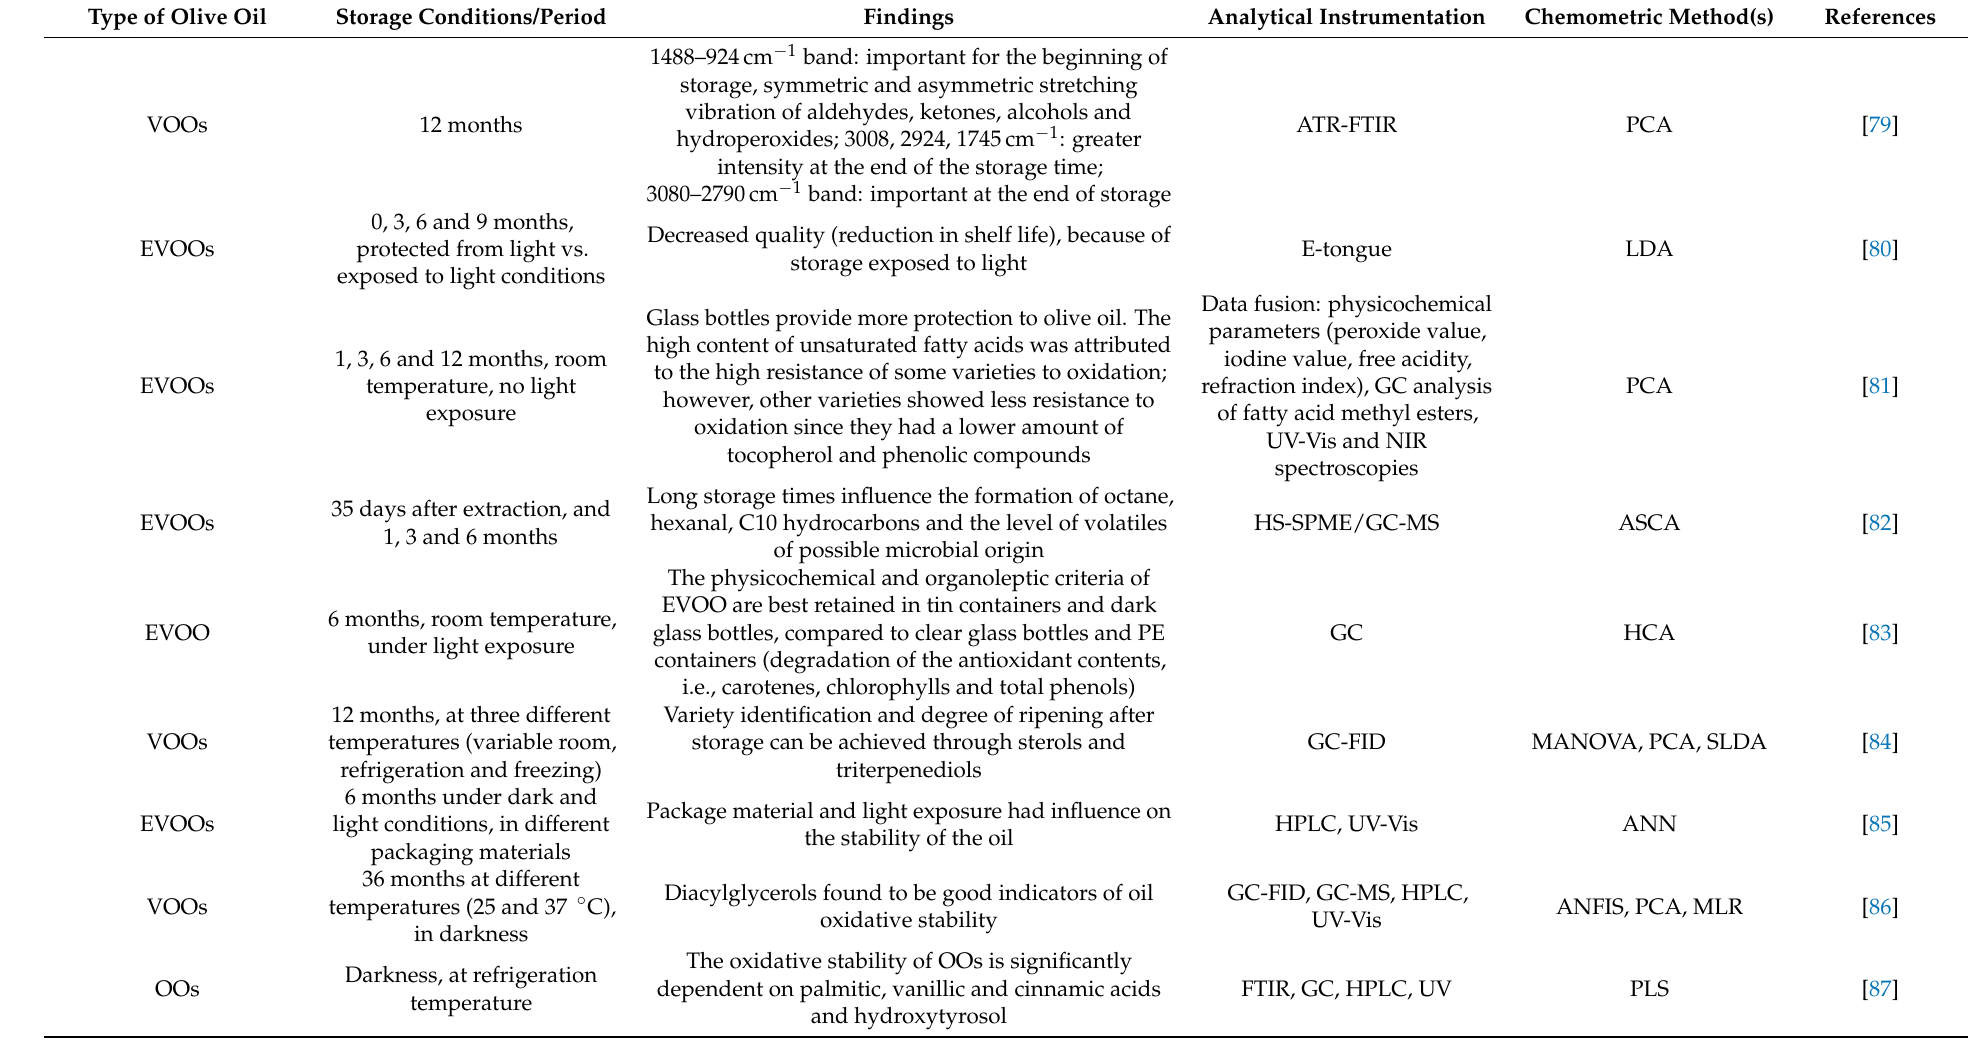
Table 2. Studies with lipid changes due to storage published in